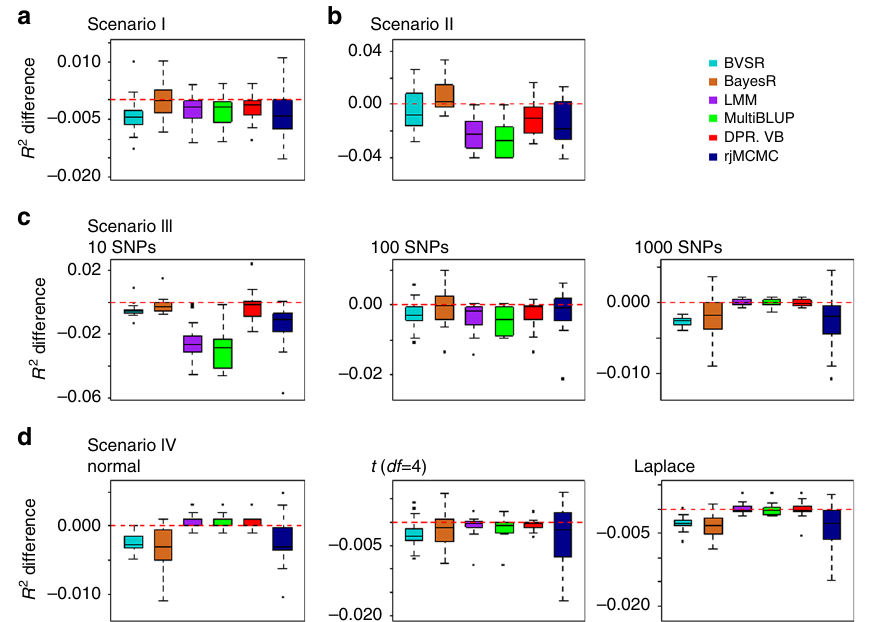
Fig. 2 Comparison of prediction performance of several methods with DPR.MCMC in simulations when PVE = 0.5. Performance is measured by R 2 difference with respect to DPR.MCMC, where a negative value (i.e., values below the red horizontal line ) indicates worse performance than DPR.MCMC. The sample R 2 differences are obtained from 20 replicates in each scenario. Methods for comparison include BVSR ( cyan ), BayesR ( chocolate ), LMM ( purple ), MultiBLUP ( green ), DPR.VB ( red ), rjMCMC ( black blue ), and DPR.MCMC. Simulation scenarios include: a Scenario I, which satis fi es the DPR modeling assumption; b Scenario II, which satis fi es the BayesR modeling assumption; c Scenario III, where the number of SNPs in the large effect group is 10, 100, or 1000; and d Scenario IV, where the effect sizes are generated from either a normal distribution, a t -distribution or a Laplace distribution. For each box plot , the bottom and top of the box are the fi rst and third quartiles, while the ends of whiskers represent either the lowest datum within 1.5 interquartile range of the lower quartile or the highest datum within 1.5 interquartile range of the upper quartile. For DPR.MCMC, the mean predictive R 2 in the test set and the standard deviation for the eight settings are, respectively, 0.272 (0.031), 0.299 (0.026), 0.295 (0.026), 0.281 (0.030), 0.277 (0.035), 0.278 (0.030), 0.282 (0.025), and 0.273